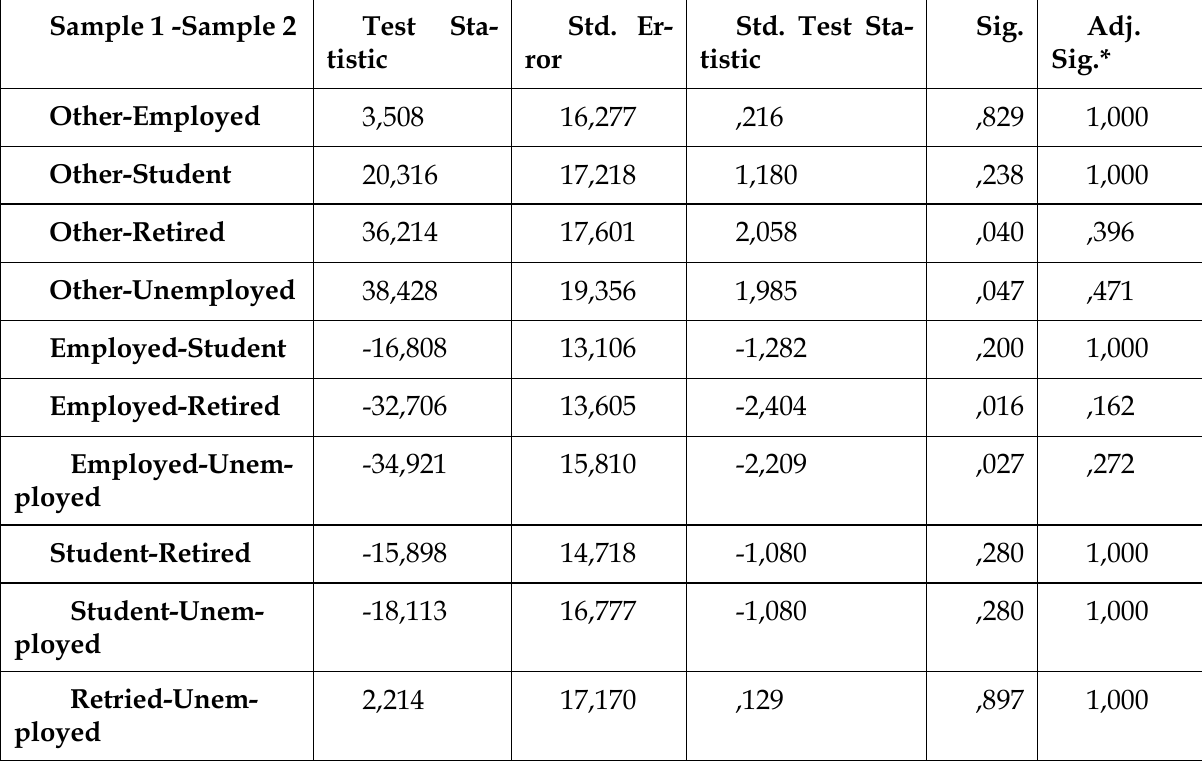
Table 20. Trust towards the health Centre and occupation. Pairwise comparison (Bonferroni). Each row tests the null hypothesis that the Sample 1 and Sample 2 distributions are the same. Asymptotic significances (2- sided tests) are displayed. *Significance values have been adjusted by the Bonferroni correction for multiple